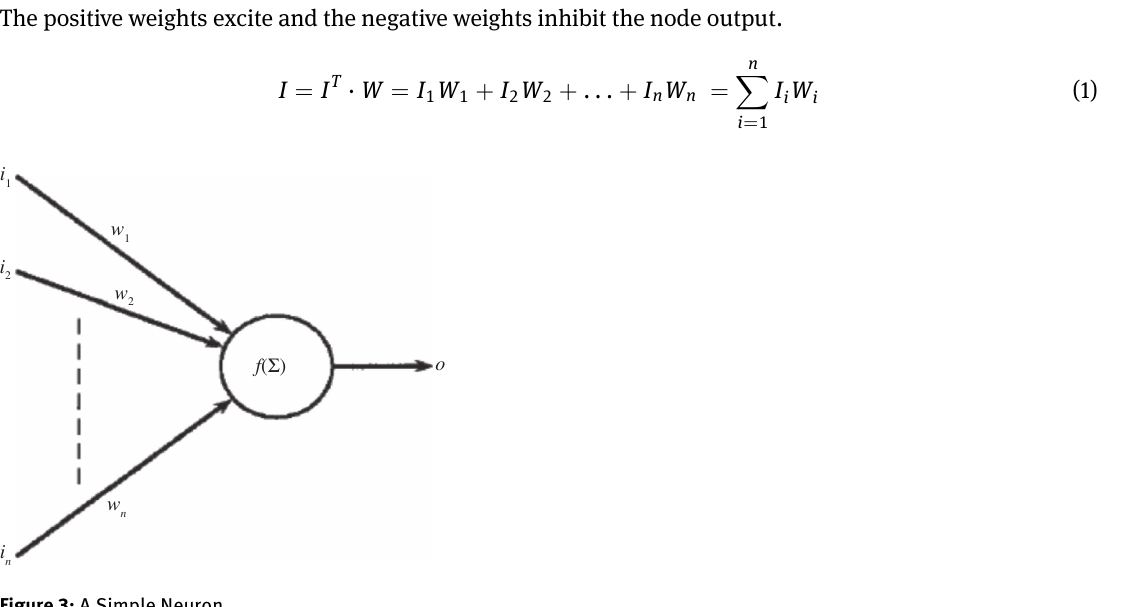
Figure 3: A Simple